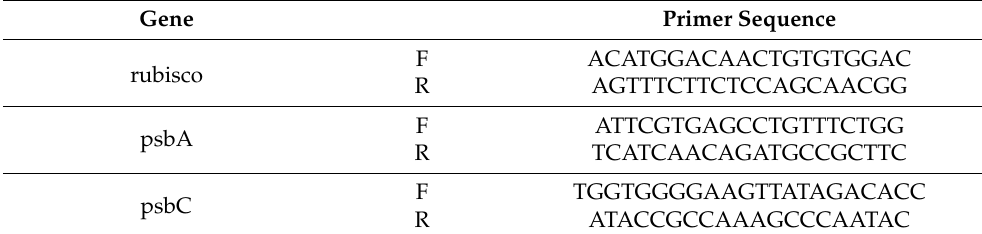
Table 1. Primers used for gene expression